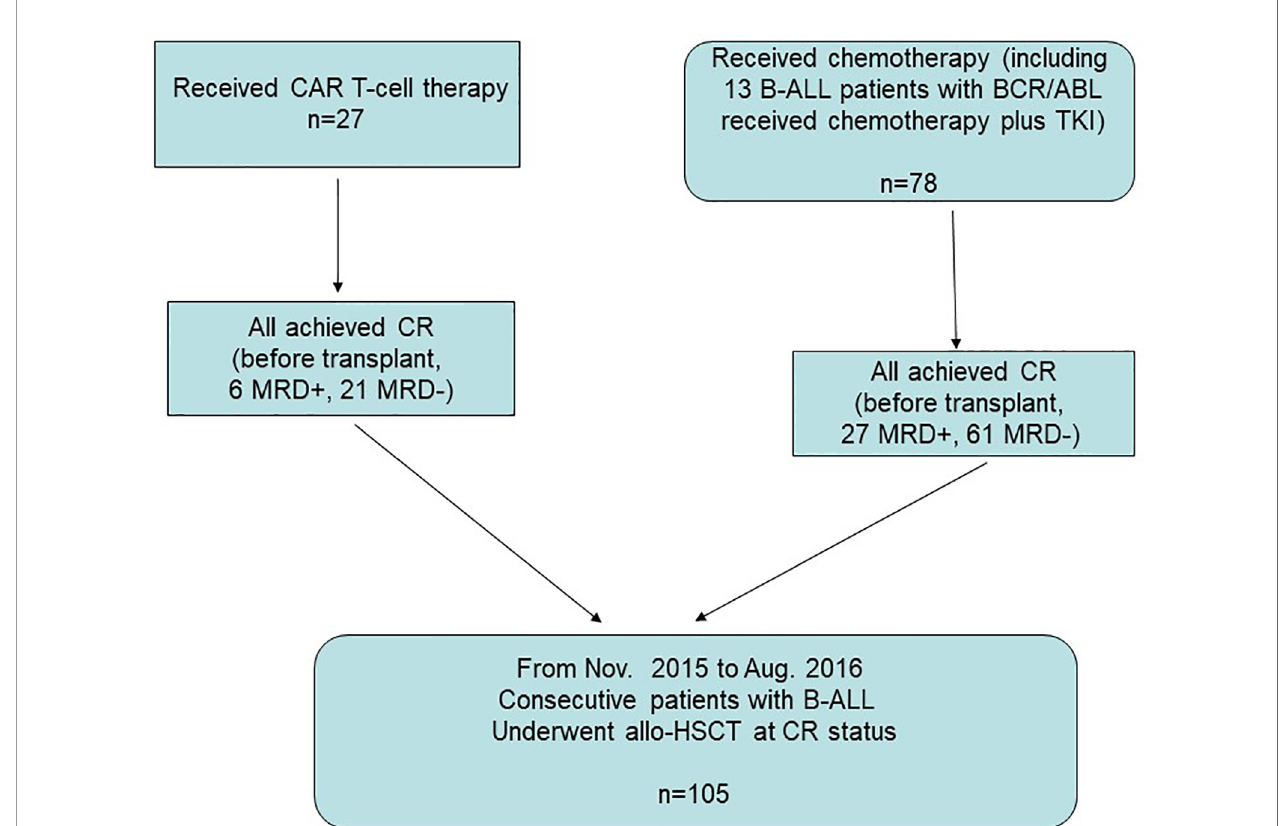
FIGURE 1 | Enrollment, and parallel comparison. Between November 2015 and August 2016, 105 consecutive B-ALL patients who underwent allo-HSCT after achieving CR either from CAR-T therapy (n=27) or chemotherapy (n=78) were enrolled for parallel